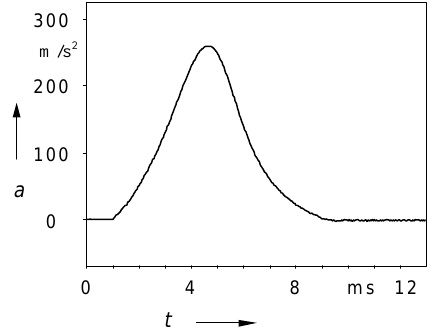
Fig. 11. Acceleration curve of a measured sine squared impulse.